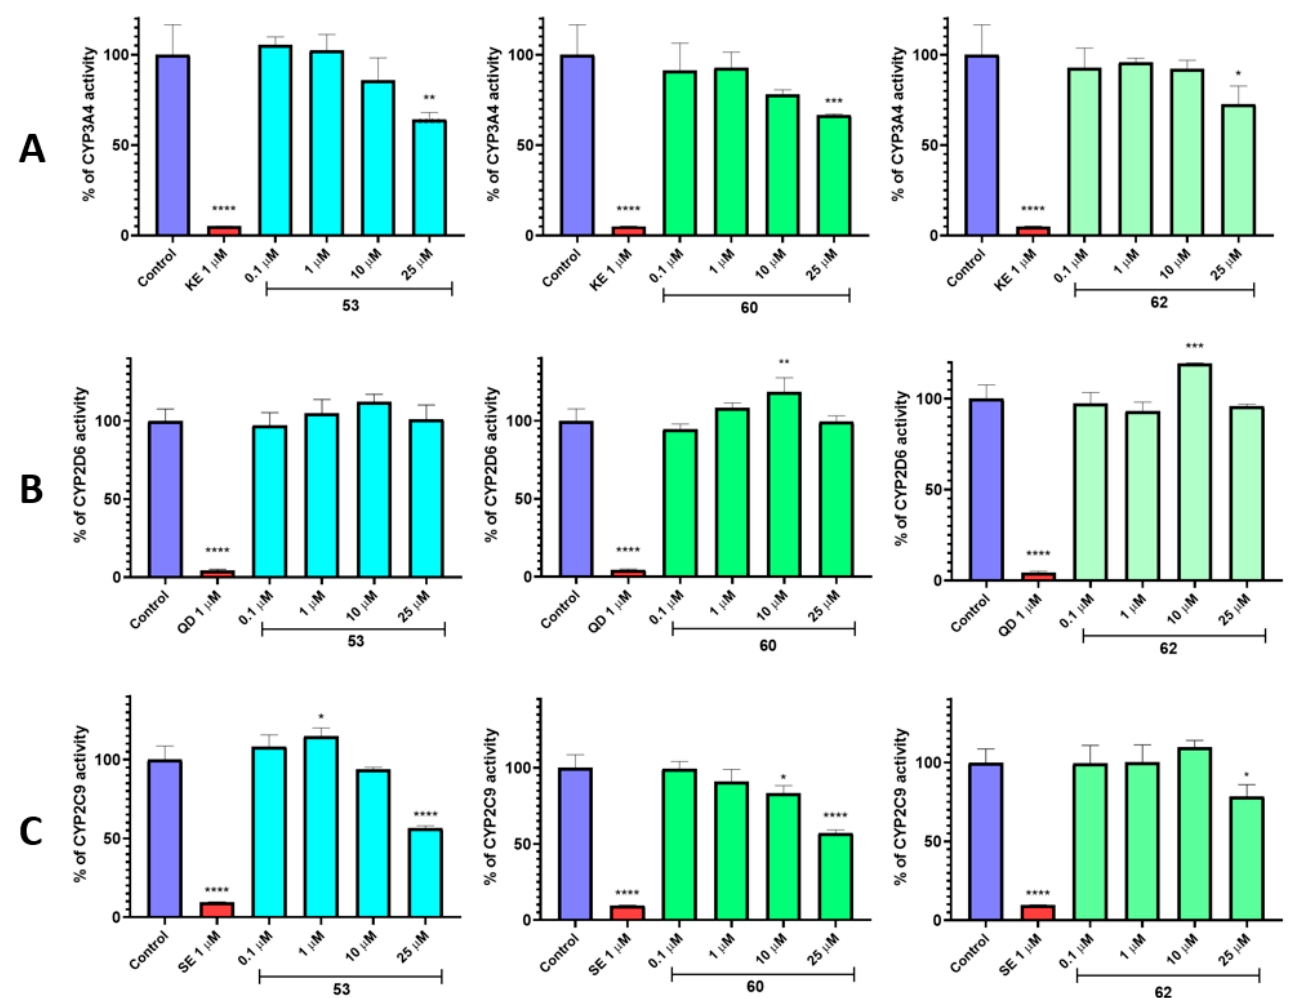
Figure 6. The influence of 53 , 60 , and 62 on: CYP3A4 activity ( A ) and the reference inhibitor ketoconazole (KE); CYP2D6 activity ( B ) and the reference inhibitor quinidine (QD); CYP2C9 activity ( C ) and the reference inhibitor sulfaphenazole (SE). The data were analyzed with one-way ANOVA, followed by Bonferroni’s Multiple Comparison Post Test (Graph Pad Prism 8.0.1 software, San Diego, CA, USA)): * p < 0.05, ** p < 0.01, *** p < 0.001 **** p < 0.0001. The compounds were examined in